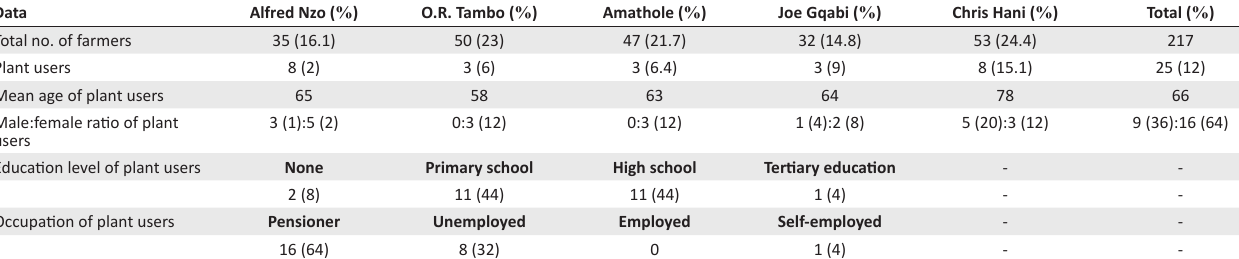
TABLE 1: Demographic information of respondents.